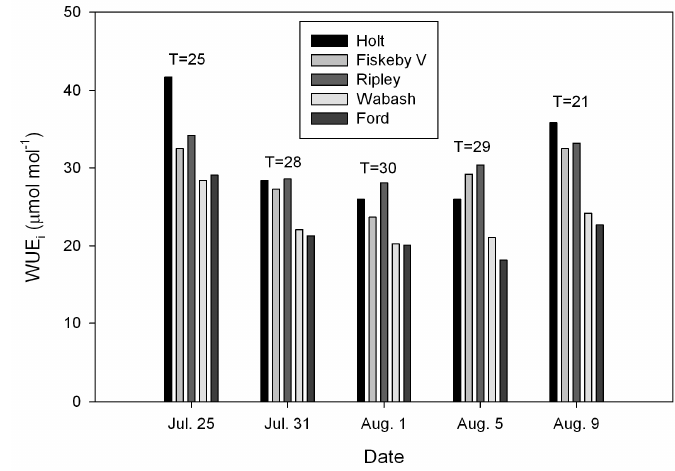
Figure 1. Intrinsic leaf water-use efficiency (WUE i ) in five cultivars of soybeans measured on five dates in 2017. Air temperatures (°C) during the measurements on each date are provided.